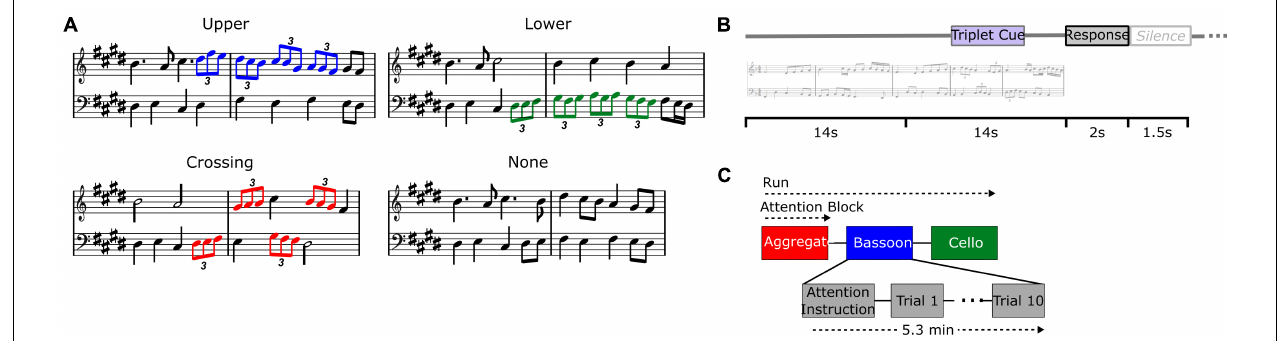
FIGURE 1 | Experiment design. Different triplet versions for each music composition (A) : upper voice (i.e., bassoon; blue notes), lower voice (i.e., cello; green notes), crossing voices (red notes), no triplets. Trial buildup (B) with 28 s stimulus, 2 s response window, and 1.5 s silence. Trials were presented in attentive blocks of 10 stimuli each and preceded by a visual attention instruction and silence (C)